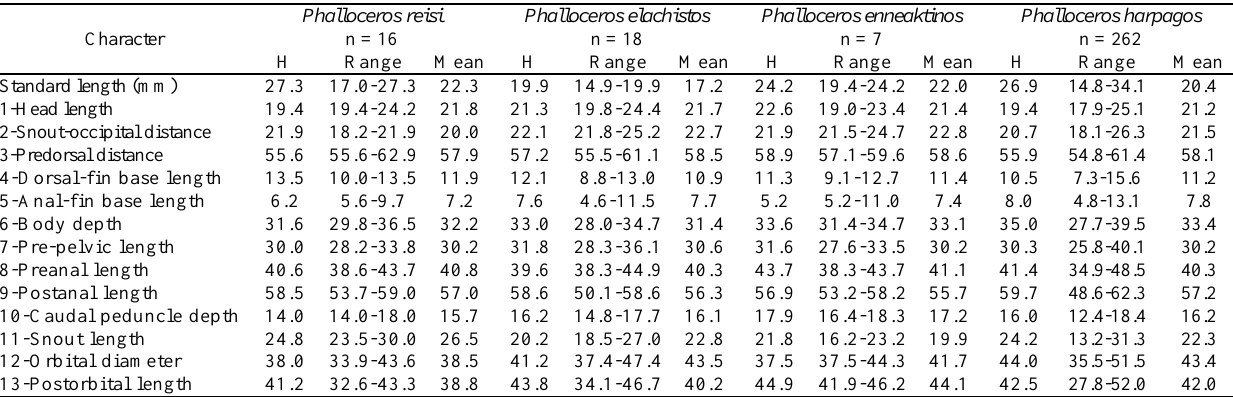
Table 10. Descriptive morphometrics of male specimens of Phalloceros reisi , P . elachistos , P . enneaktinos , and P . harpagos . Measurements 1-10 are percents of standard length and measurements 11-13 are percents of head length. H = holotype.